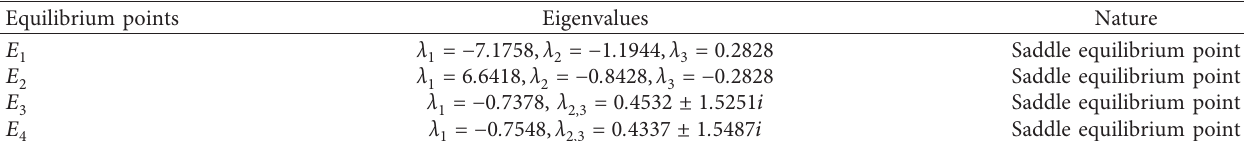
Table 1: Equilibrium points, corresponding eigenvalues, and their